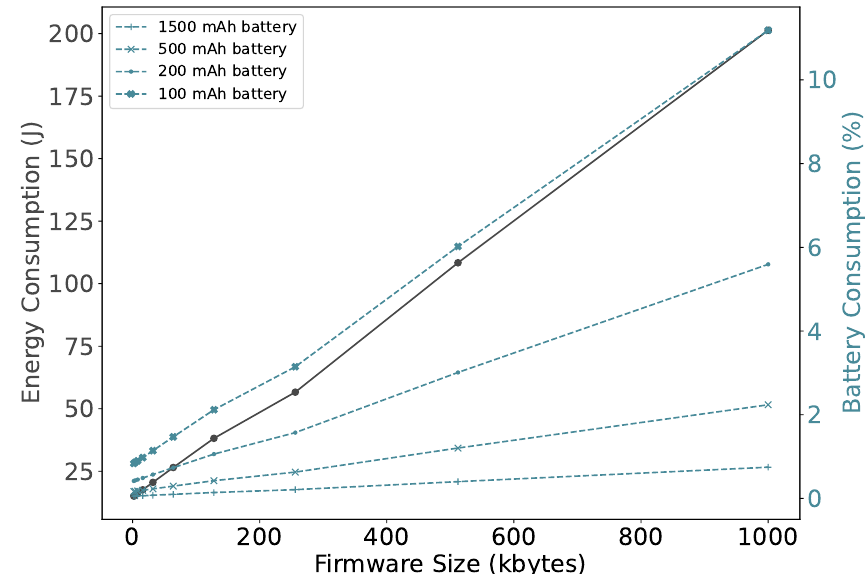
Figure 12. Bootloader firmware update operations.